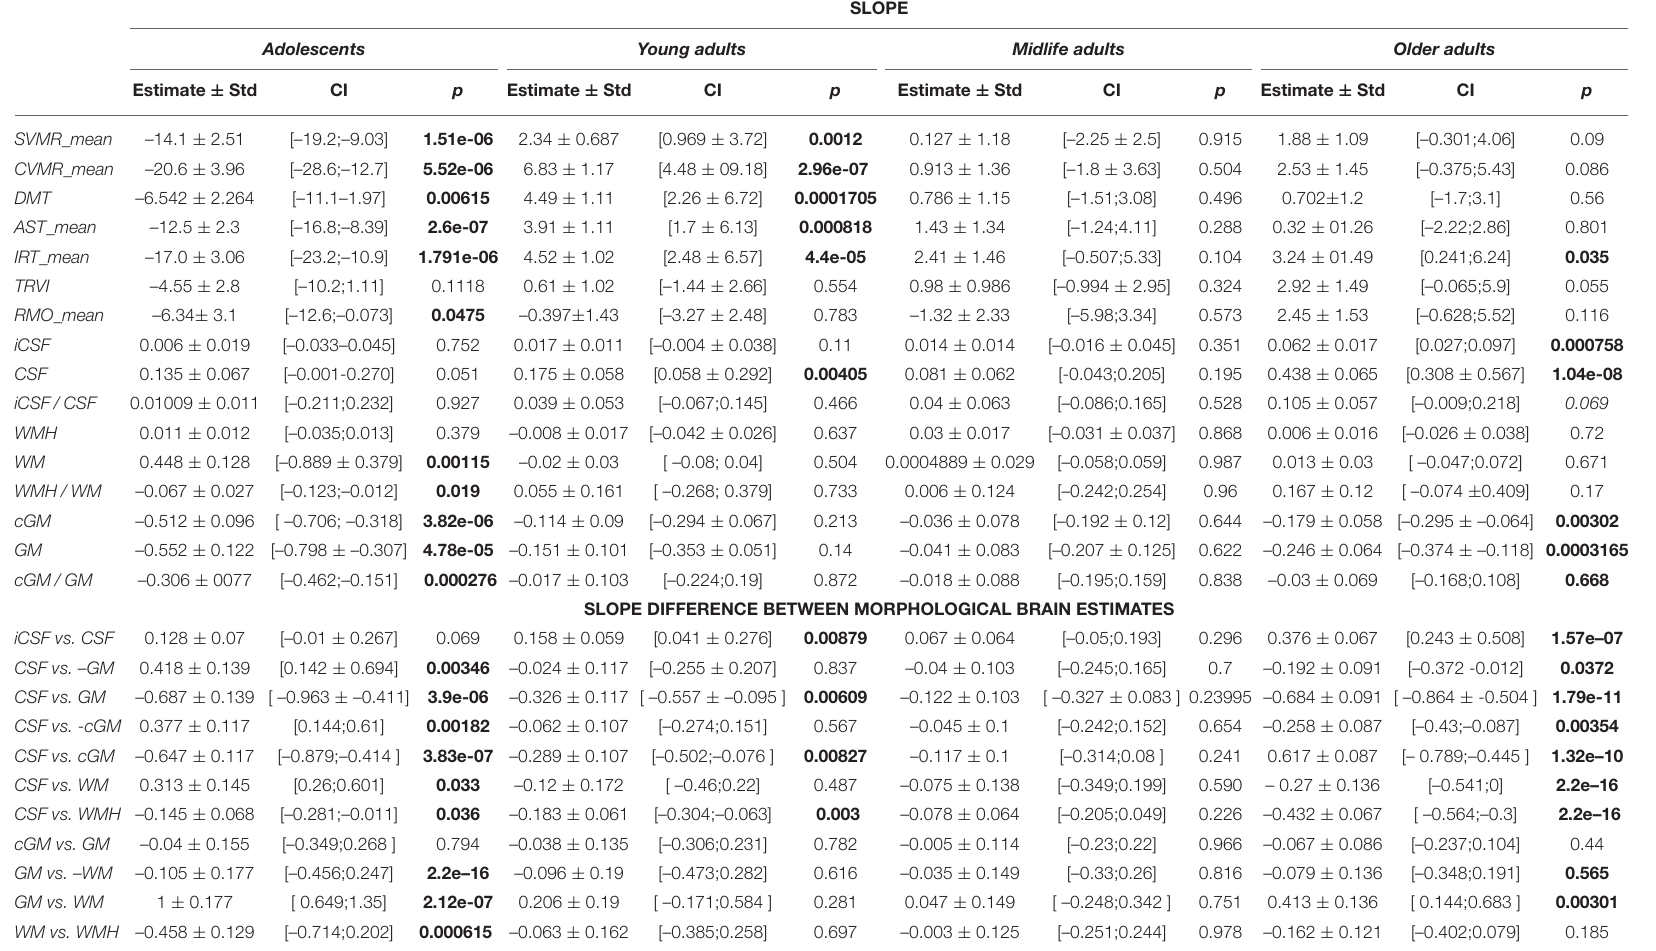
TABLE 2 | Interaction coefficients for comparison of slopes for psycho-physiological performance and brain